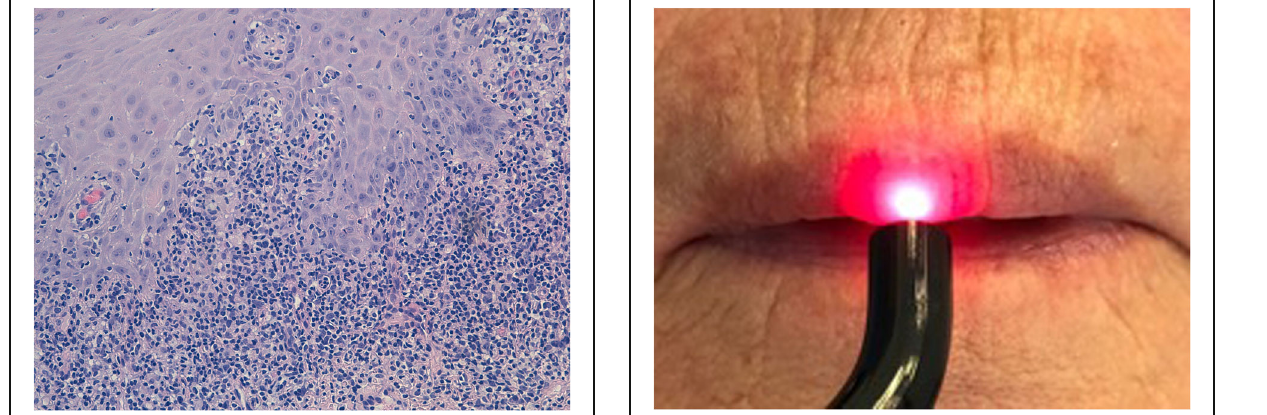
Fig. 3 20× (E&E): Polymorphous lymphomonocytic inflammatory infiltrate with affected basal lamina of the oral mucosa